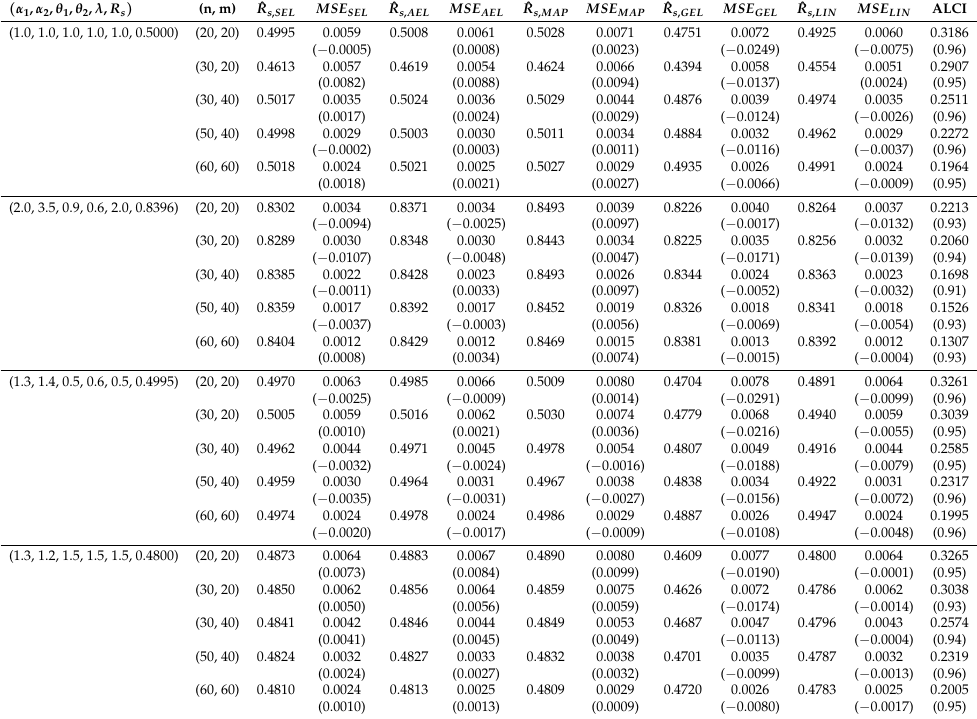
Table 2. Actual parameter values and R s ; Bayes estimates of R s under various loss functions; MSE with bias in parenthesis, ALCI with CP in parenthesis of the